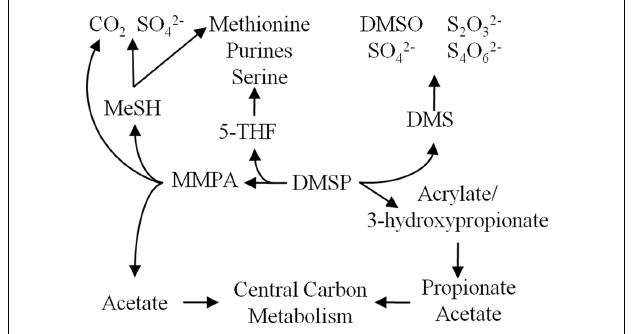
FIGURE 1 | Overview of DMSP catabolic pathways in marine bacteria and the fates of carbon and sulfur.